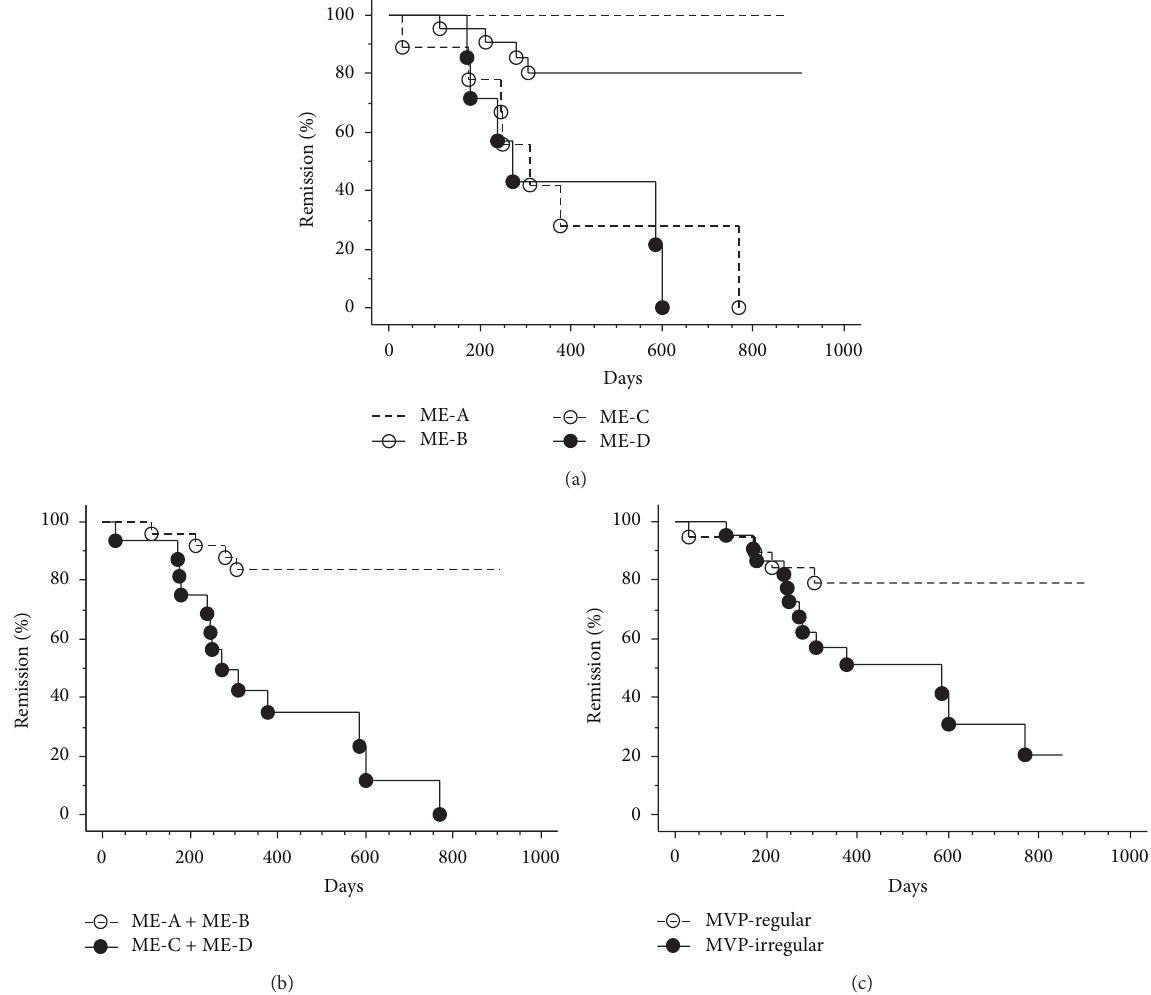
Figure 3: Comparison of the percentage of patients in remission on the basis of the ME classifications with vital staining or NBI using the Kaplan-Meier method. There are significant differences in the percentages of the remission of UC among the ME classifications (a), between ME-A plus ME-B group and the ME-C plus ME-D group (b), and between the MVP-regular and MVP-irregular type (c).